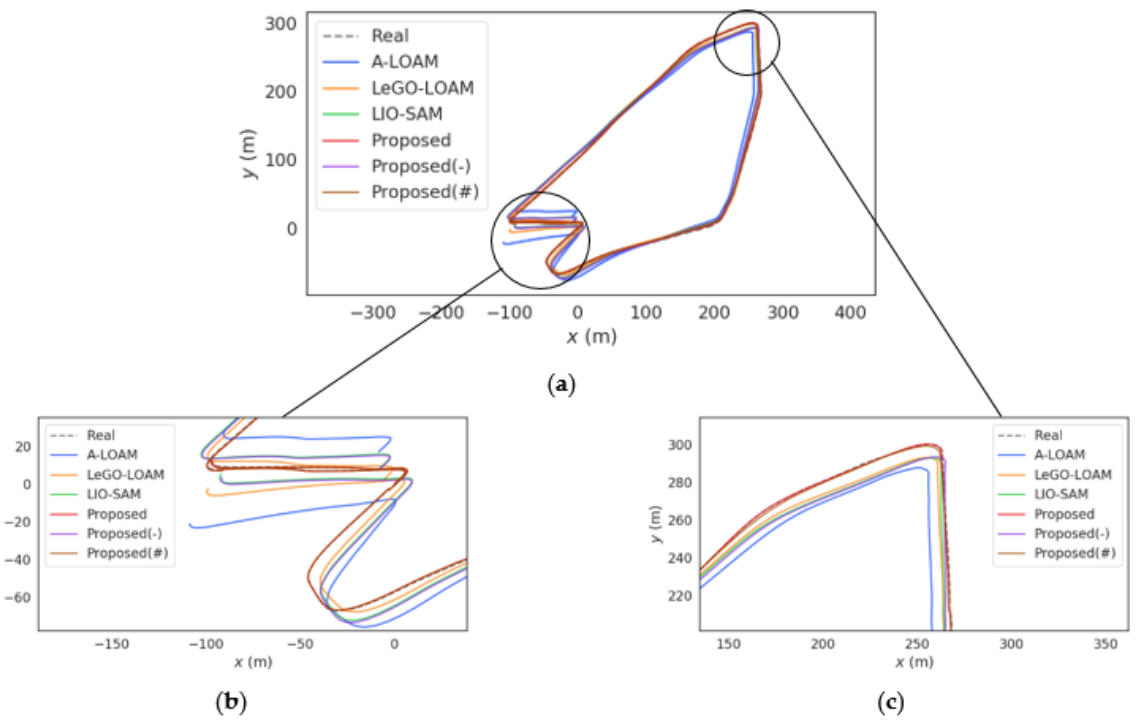
Figure 12. Comparison of the estimated trajectories. ( a ) Global positioning trajectory. ( b ) Local details of the trajectory. ( c ) Local details of the trajectory. Table 5. Motion estimation errors of each algorithm on outdoor